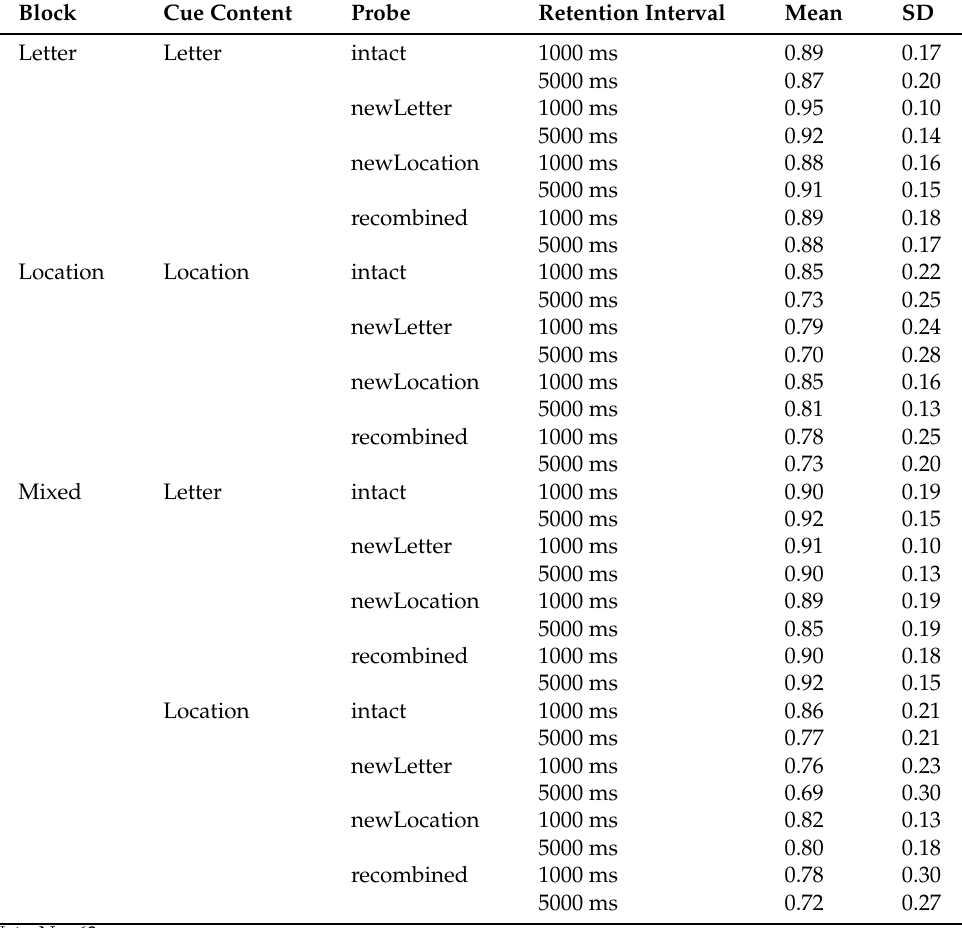
Table 3. Mean proportion correct (with standard deviations) per cue content, probe type, and retention interval, Experiment